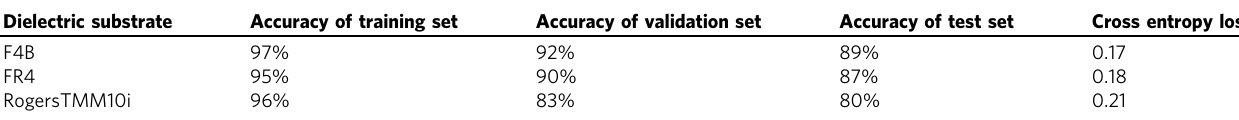
Table 3 The DLN performances of different materials.